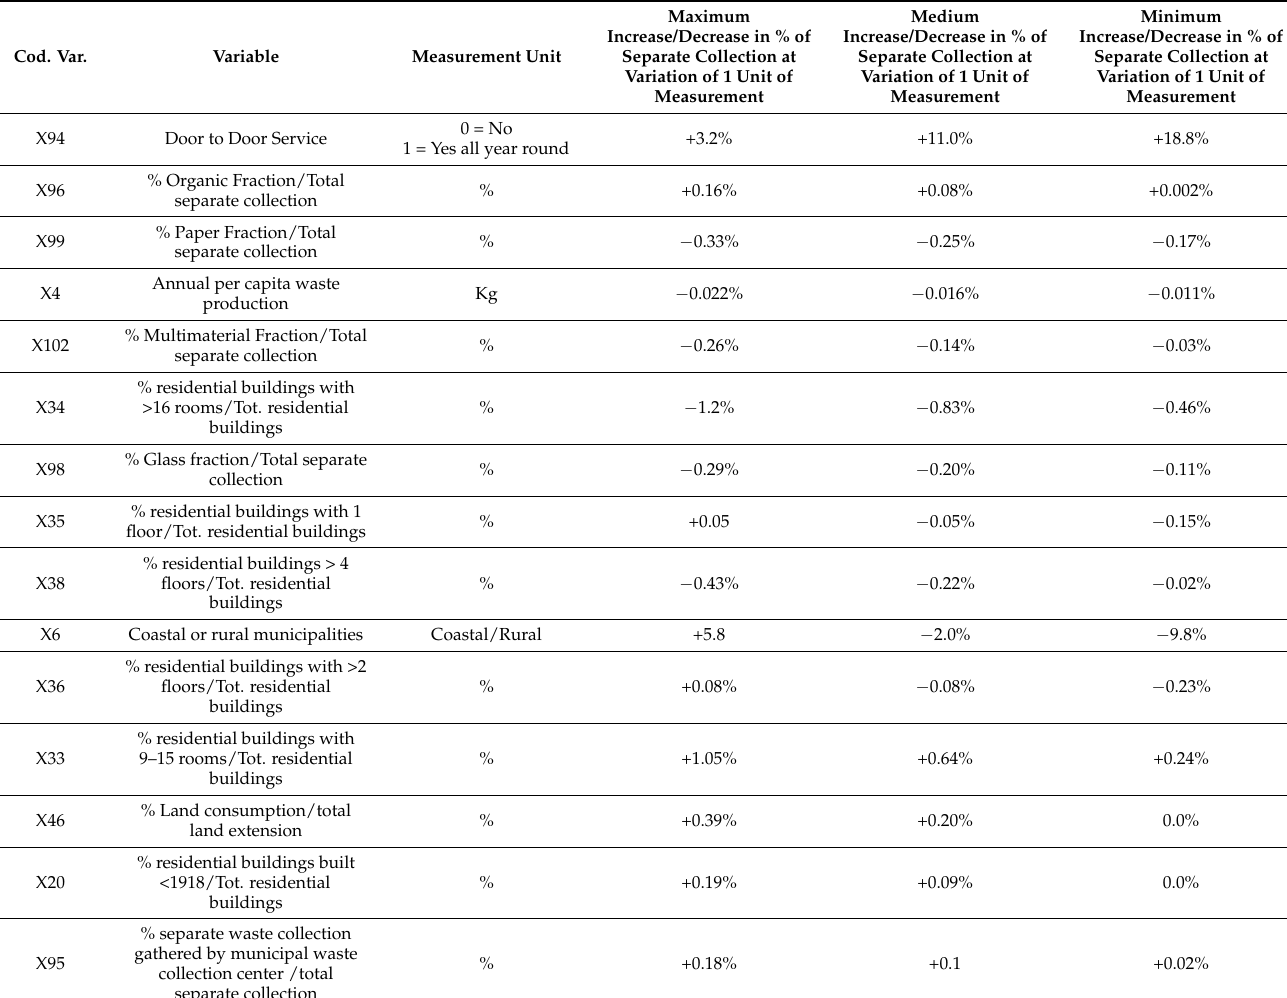
Table 2. Percentage of separate collection: Range of the average increase/decrease per unit of measurement of each of the 16 variables shown in Figure